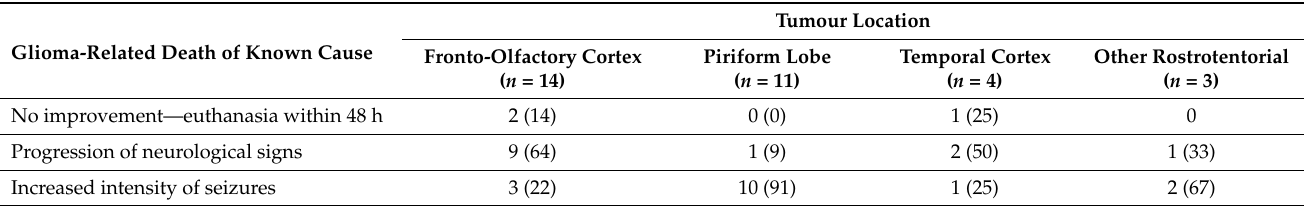
Figure 6. Survival curves for dogs with presumed glioma located in the fronto-olfactory cortex (F- O) with contrast enhancement (CE) and located in other rostrotentorial regions without CE. Broken lines stand for 95% confidence intervals (CI 95%) for estimated survival curves.